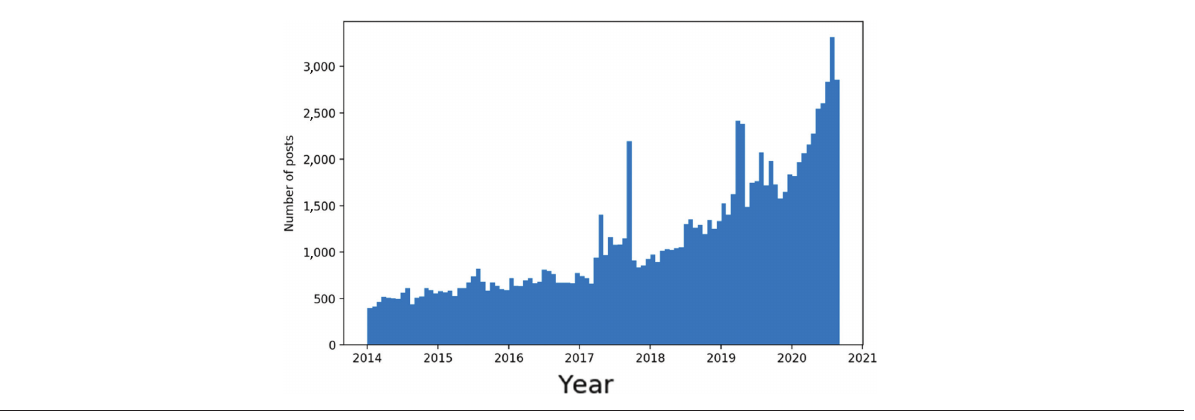
Figure 8. Rise in Reddit activity related to Saturn (Source: Authors,